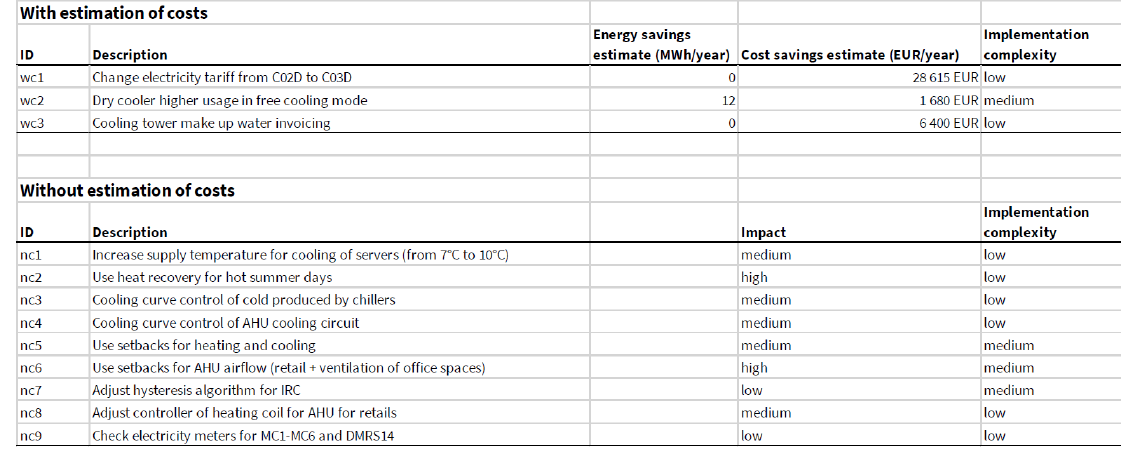
Table 1 Recommendation for savings. (Source: authors with the use of [9])